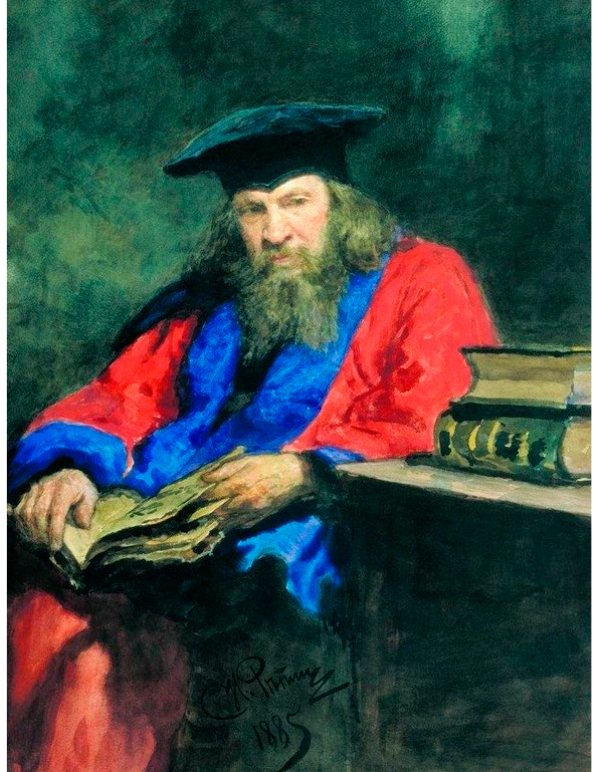
Figure 7. Repin I.E (1885). Mendeleev in the mantle of Edinbourgh University honorable professor (permission of Tretyakov Gallery,